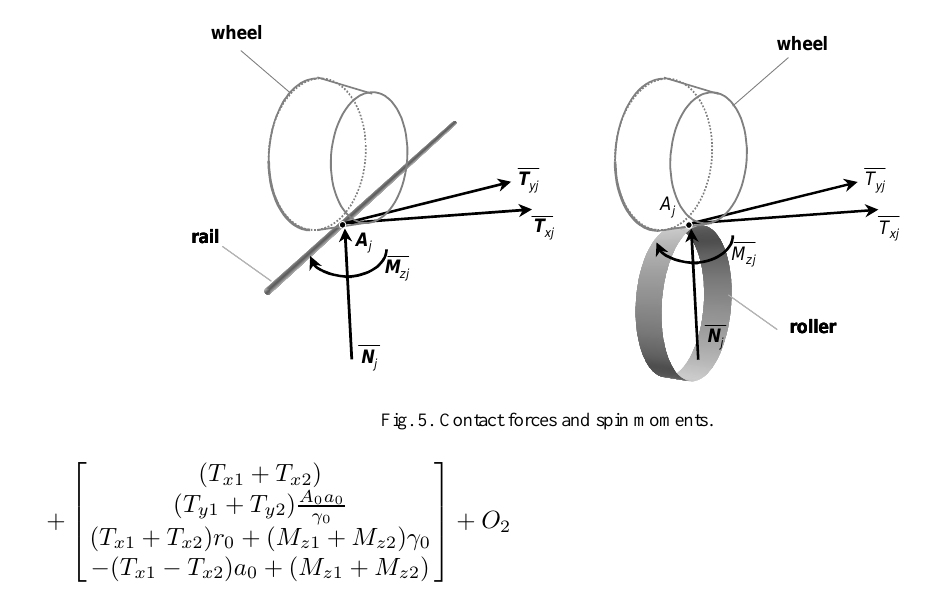
Fig. 5. Contact forces and spin